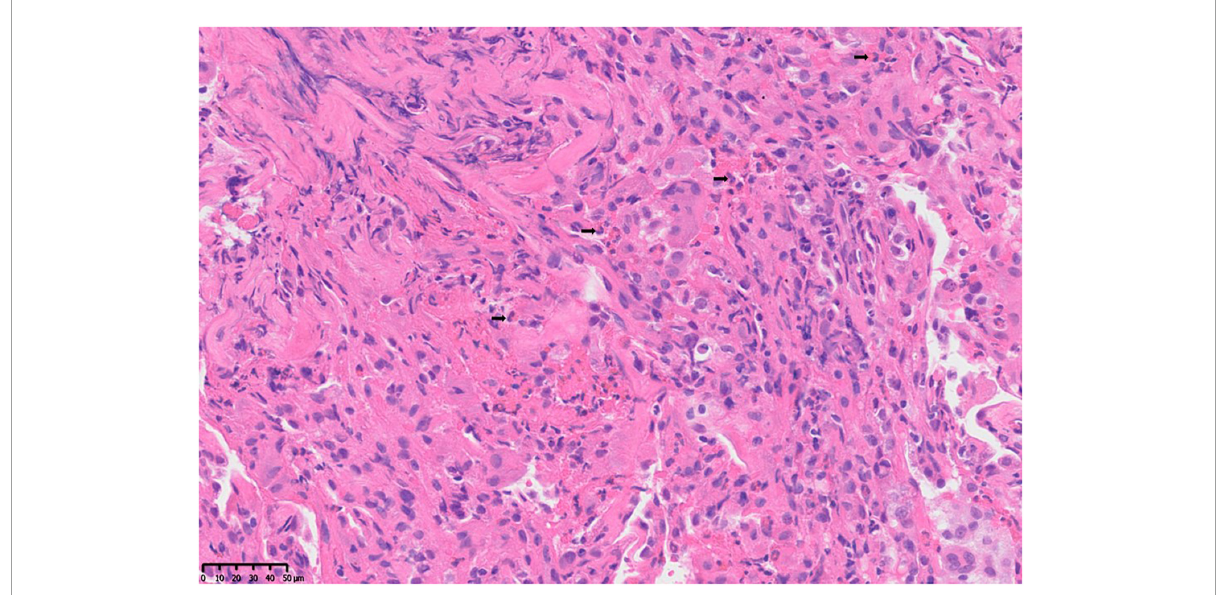
FIGURE2 Pathological changes of lung tissue: microscopic finding of the right lower lung shows a heavy eosinophilic infiltration, > 20 eosinophils per high power field (H and E, × 400).